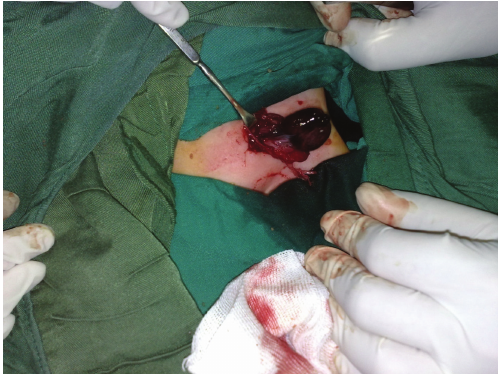
Figure 1: Swollen left inguinal area is evident. Figure 2: Necrotic testis with its overlying layers.